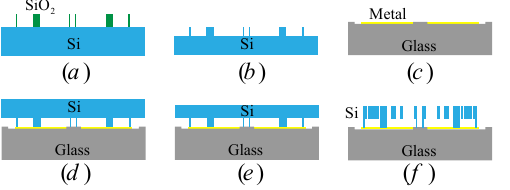
Figure 4. The procedures of the DDSOG technology. ( a ) Anchoring on the silicon wafer. ( b ) Etching the bonding area on the silicon wafer. ( c ) Depositing the metal conductive layer onto the glass substrate wafer. ( d ) Bonding the silicon wafer to the glass substrate wafer by anodic bonding. ( e ) Thinning and polishing the silicon wafer. ( f ) Inductively coupled plasma (ICP) etching and structure releasing.